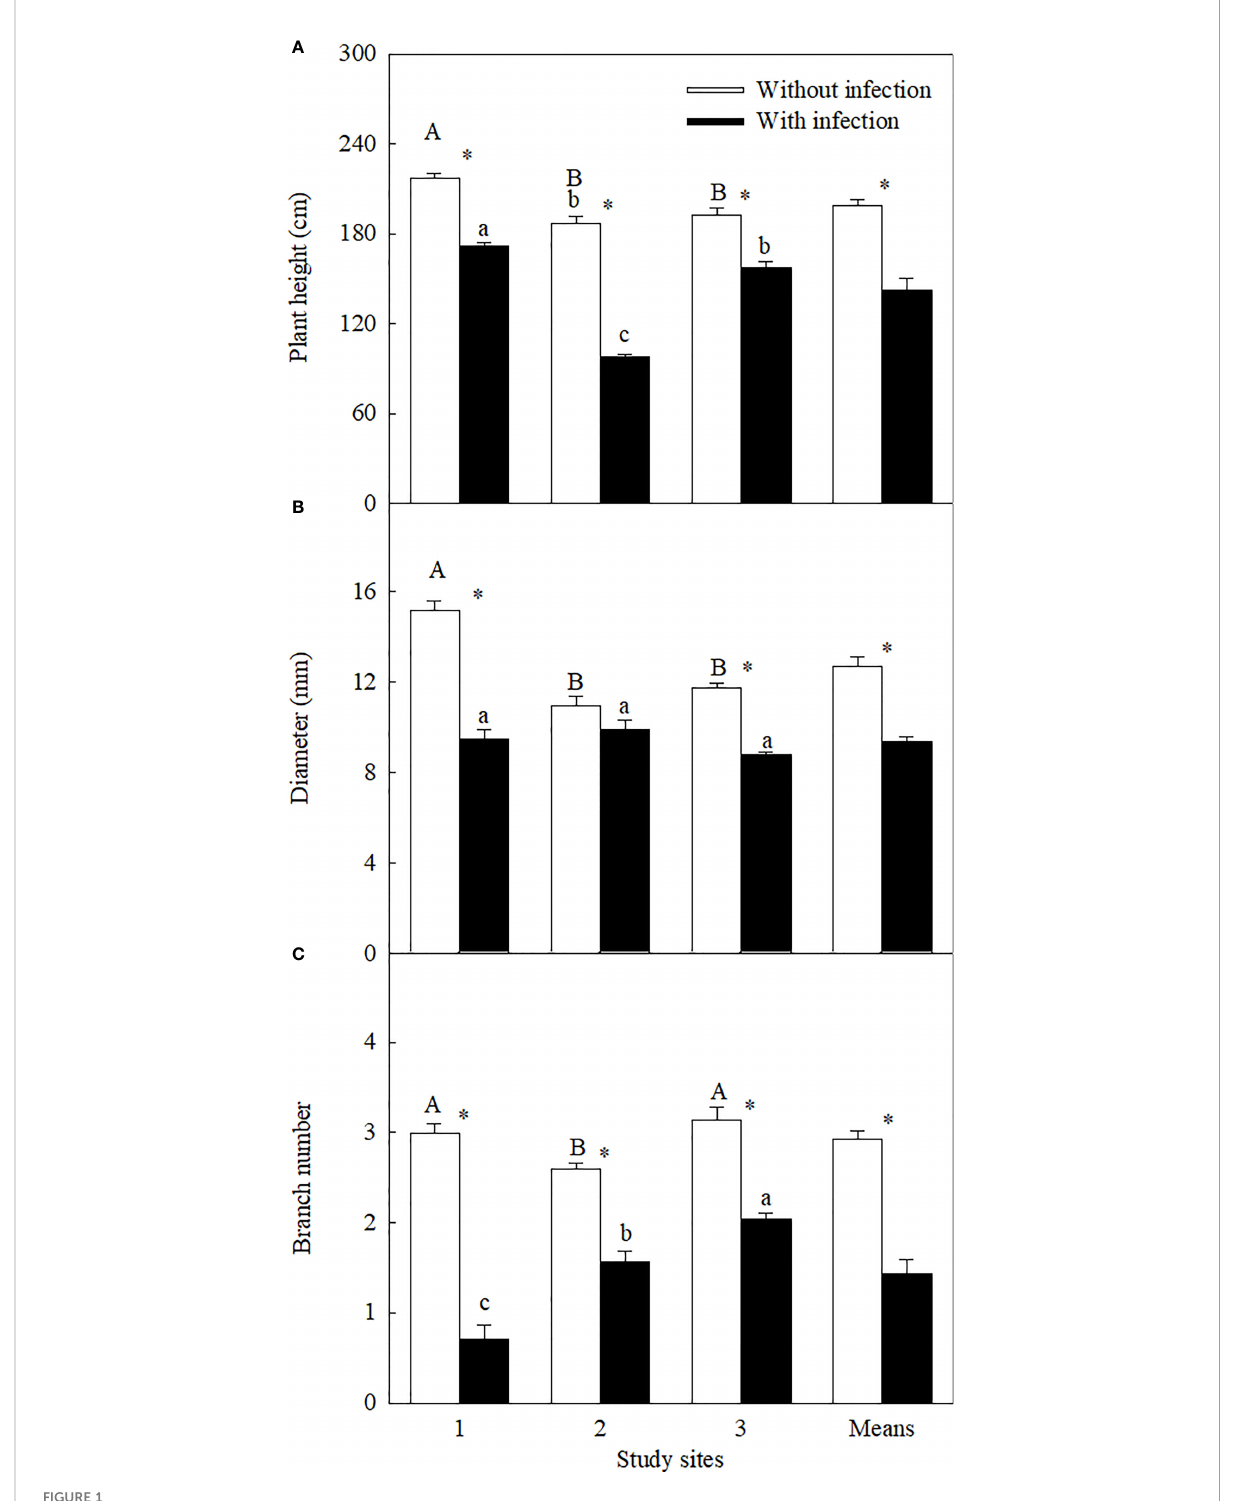
FIGURE 1 Plant height (A) , stem diameter (B) , and branch number (log 3 -transformed;) (C) of Ambrosia tri fi da uninfected (open bars) and infected (closed bars) by Cuscuta japonica at different sites. Means + 1 SE ( n = 6). Different upper- and lowercase letters indicate signi fi cant differences among sites for uninfected and infected plants, respectively ( P < 0.05; one-way ANOVA); * indicates signi fi cant difference between uninfected and infected plants at the same site ( P < 0.05; independent sample t